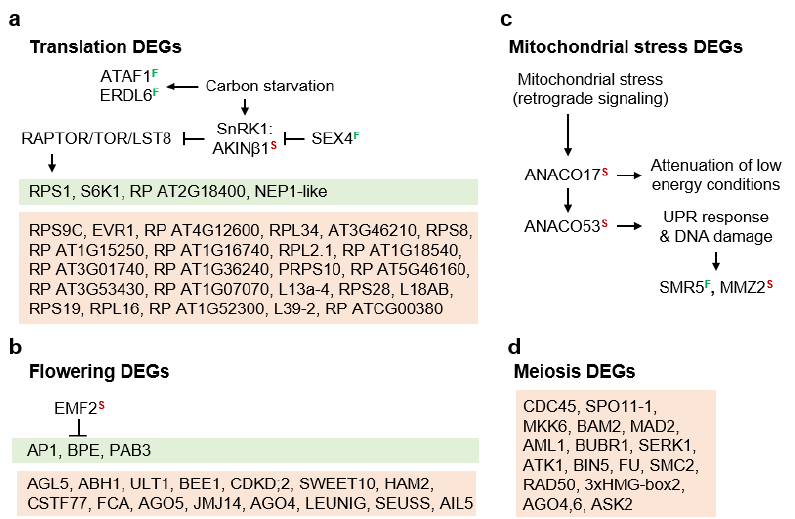
Figure 4. Differentially expressed genes (DEGs) observed between diplosporous Boechera x formosa and sexual Boechera stricta (Tables S5 and S9) as associated with: ( a ), translation; ( b ), flowering; ( c ), mitochondrial stress; and ( d ), meiosis. Superscripts identify taxa in which DEGs are upregulated; F, B. × formosa ; S, B. stricta ; red and green highlights, up or downregulation in B. stricta , respectively; arrows indicate upregulation or activation; blunt end lines represent downregulation or suppression; RP, ribosomal protein; UPR, unfolded protein response.